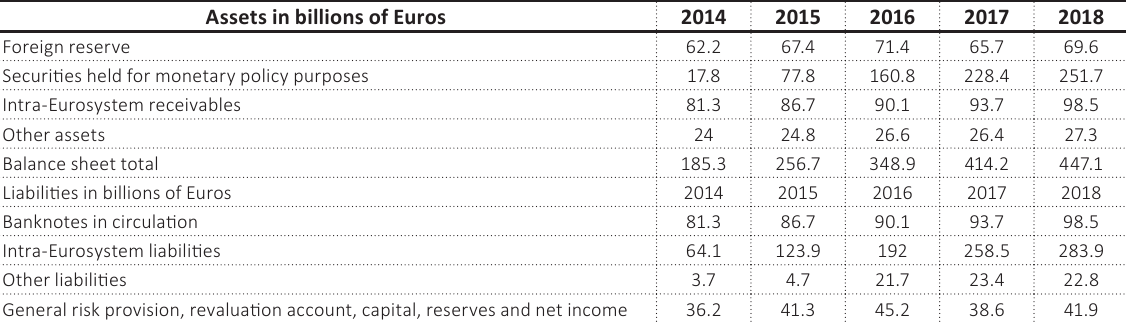
Table 3. ECB balance sheets total and securities held for monetary policy purposes